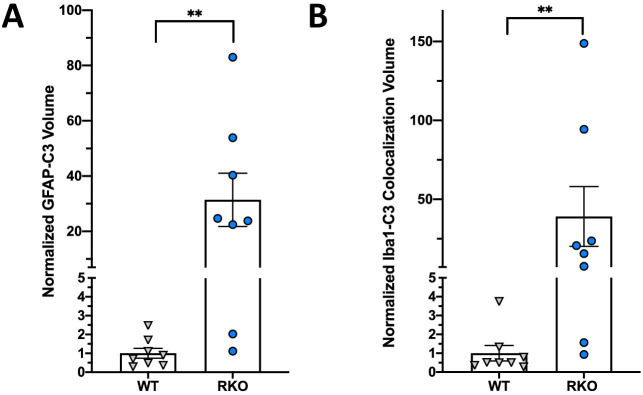
C3 colocalization with astrocytes and microglia in RKO brain.Normalized colocalized volume quantification for C3-GFAP staining from Figure 1G (A) and C3-Iba1 staining from Figure 1H (B) (N = 8 mice/group). In all panels, each point represents the average of 3 sections from a single mouse. **p<0.01 by two-tailed T-test with Welch’s correction.